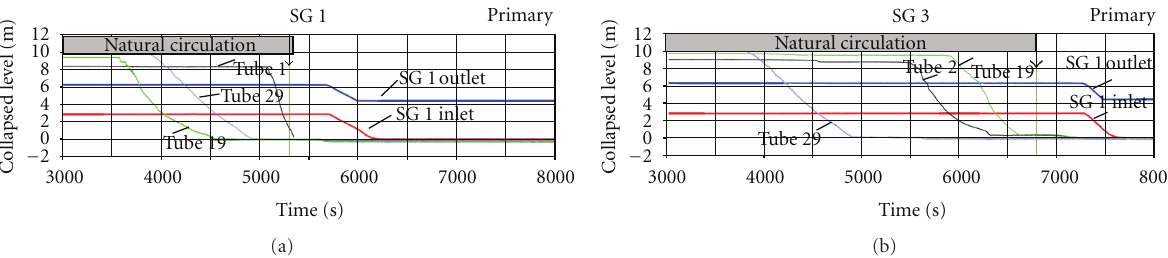
Figure 10: (a) Run-1: Measured collapsed levels in the U-tubes of the inactive loop-1. (b) Run-1: Measured collapsed levels in the U-tubes of the inactive loop-3.